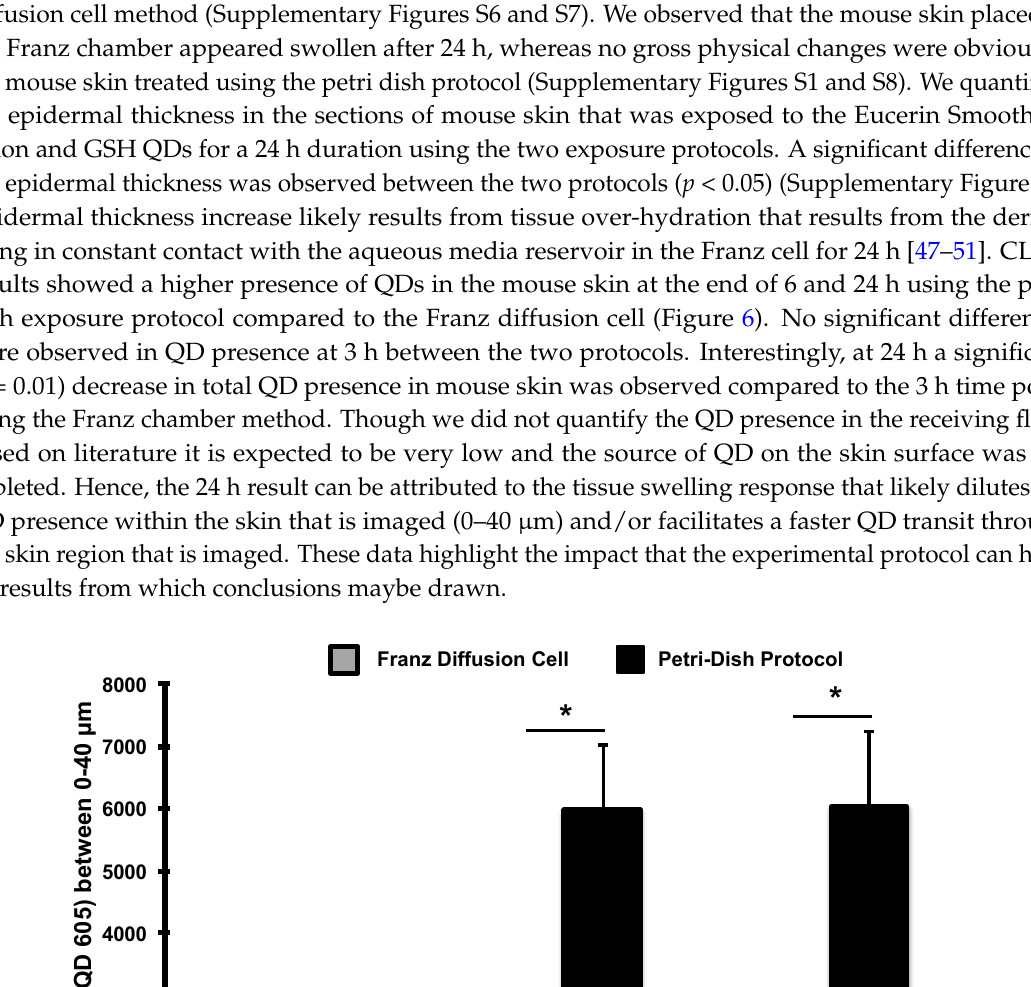
Figure 6. QDs penetrate faster through ex vivo mouse skin in the Franz Diffusion Chamber as compared to the petri-dish protocol. The total QD fluorescence signal integrated from 0 to 40 µm was used to quantify the differences in QD epidermal presence in ex vivo mouse skin at 3, 6 and 24 h using the petri-dish and Franz cell protocol. A higher presence of QDs was observed in the skin at the end of 6 and 24 h using the petri-dish protocol compared to the Franz cell. A significant decrease in QD presence was observed at 24 h compared to the 3-h time point using the Franz cell; mean ± SEM ( N = 4, n = 3). * p < 0.05 (Inter-group analysis), $ p < 0.05 (3 h vs. 24 h time point Franz cell group).